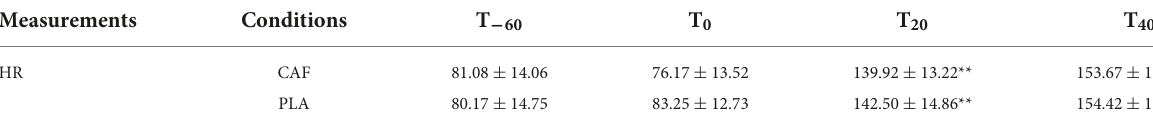
TABLE 2 Heart rate responses over the entire trial (beats/min). Measurements